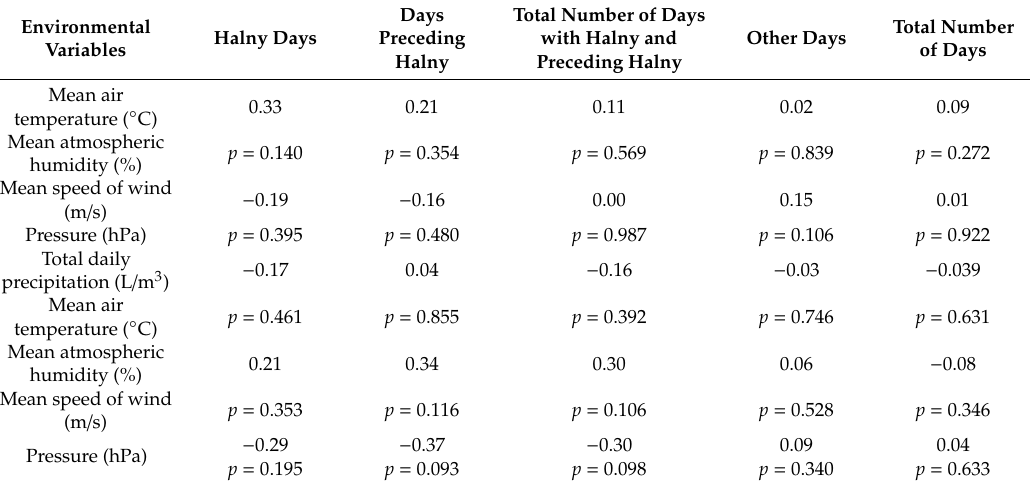
Table 6. Relationship between the number of cardiac events and environmental variables in the selected periods of time.